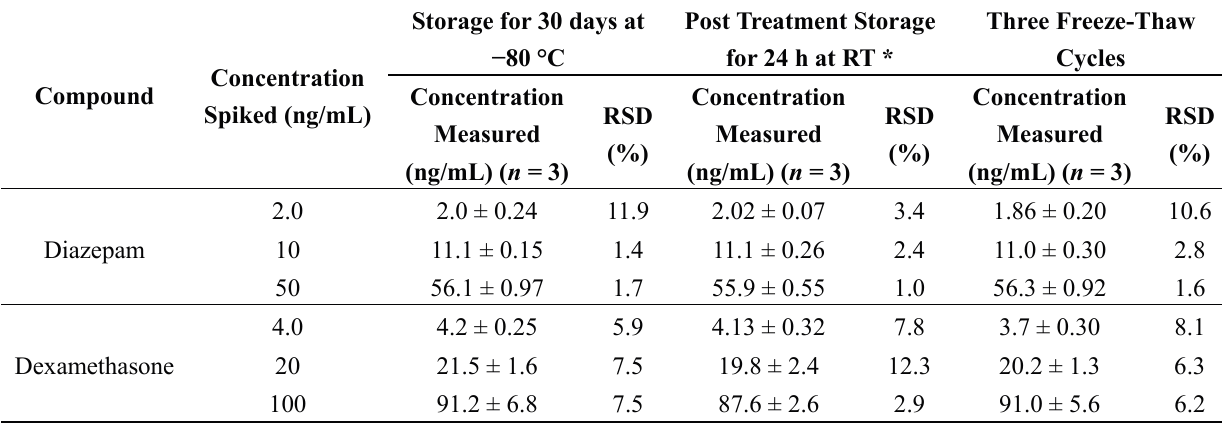
Table 3. Stability of diazepam and dexamethasone in the QC